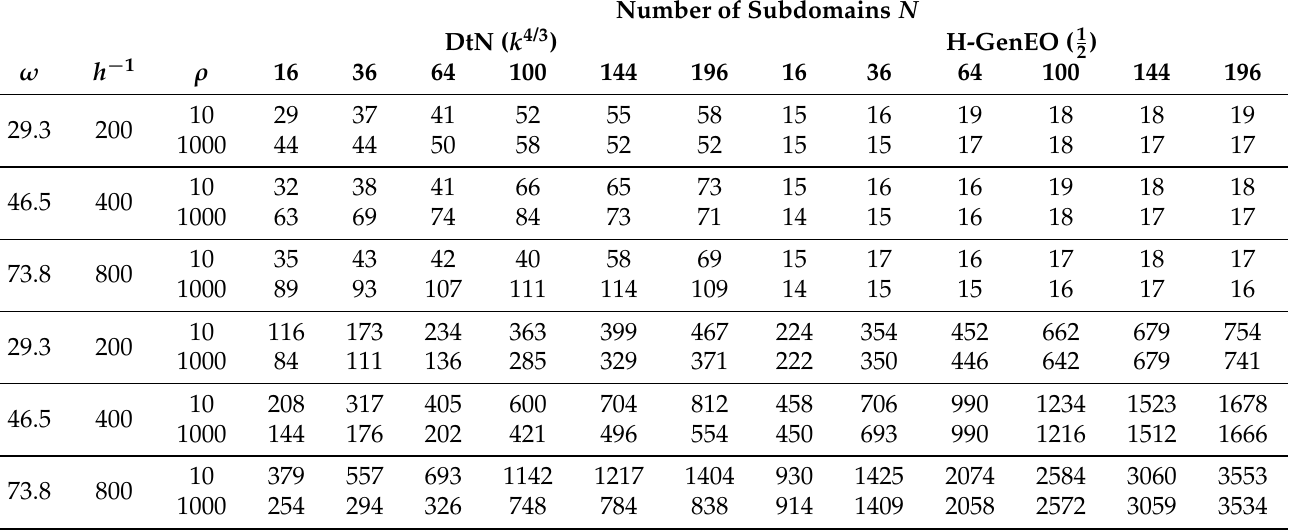
Table 5. Preconditioned GMRES iteration counts (above) and size of coarse space (below) for the heterogeneous increasing layers problem when using ORAS with DtN( k 4/3 ) or H-GenEO( 1 a varying number of subdomains. A uniform decomposition into is